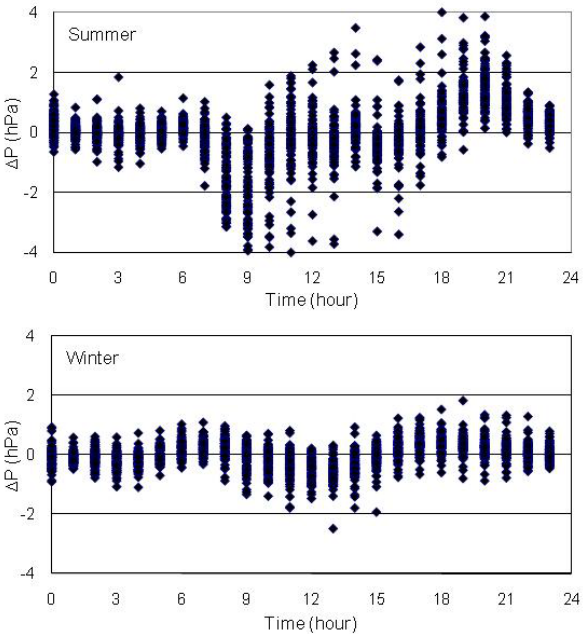
Figure 5. (Top) hourly ∆ P during summer. (Bottom) hourly ∆ P during winter.